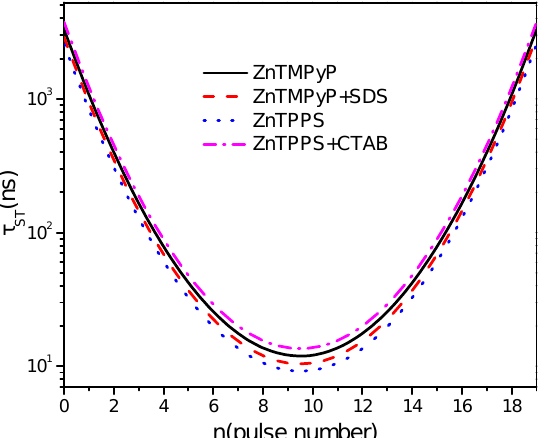
Figure 6. The effective population transfer time τ ST at L = 0 and r = 0 for ZnTMPyP and ZnTPPS in aqueous solutions and their porphyrin J-aggregates with micelles of SDS and CTAB. I 0 = 1.0 × 10 13 W/m 2 , N = 2.9 × 10 23 /m 3